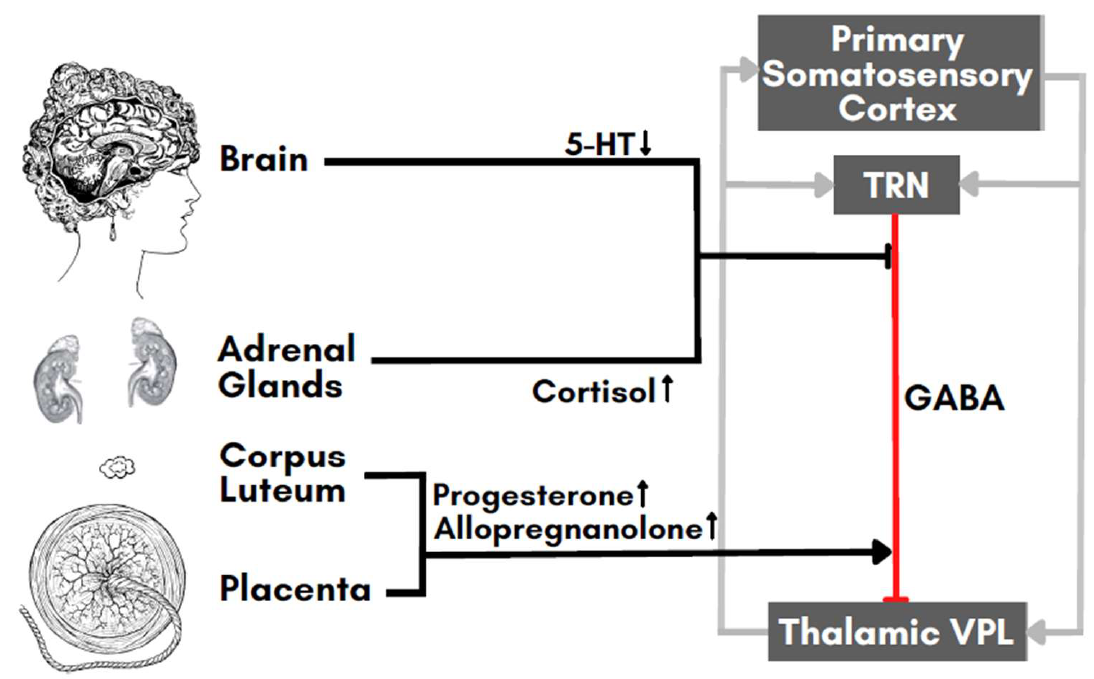
Figure 1. Effects of major pregnancy endocrine agents on the thalamocortical loop brain network representing a possible bistable switch model of FM pathogenesis. Progesterone and allopregnanolone strengthen GABAergic transmission, whereas cortisol indirectly weakens it, thereby preventing or promoting, respectively, the switching of the loop to a pathogenic functional regime. Key: Arrow line-endings indicate activation and T-shaped line-endings inhibition. TRN: thalamic reticular nucleus, VPL: ventroposterolateral nucleus. Image attributes: Henry Vandyke Carter and Pearson Scott Foresman, Public domain, via Wikimedia Commons https://commons.wikimedia.org (accessed 17/02/2023).